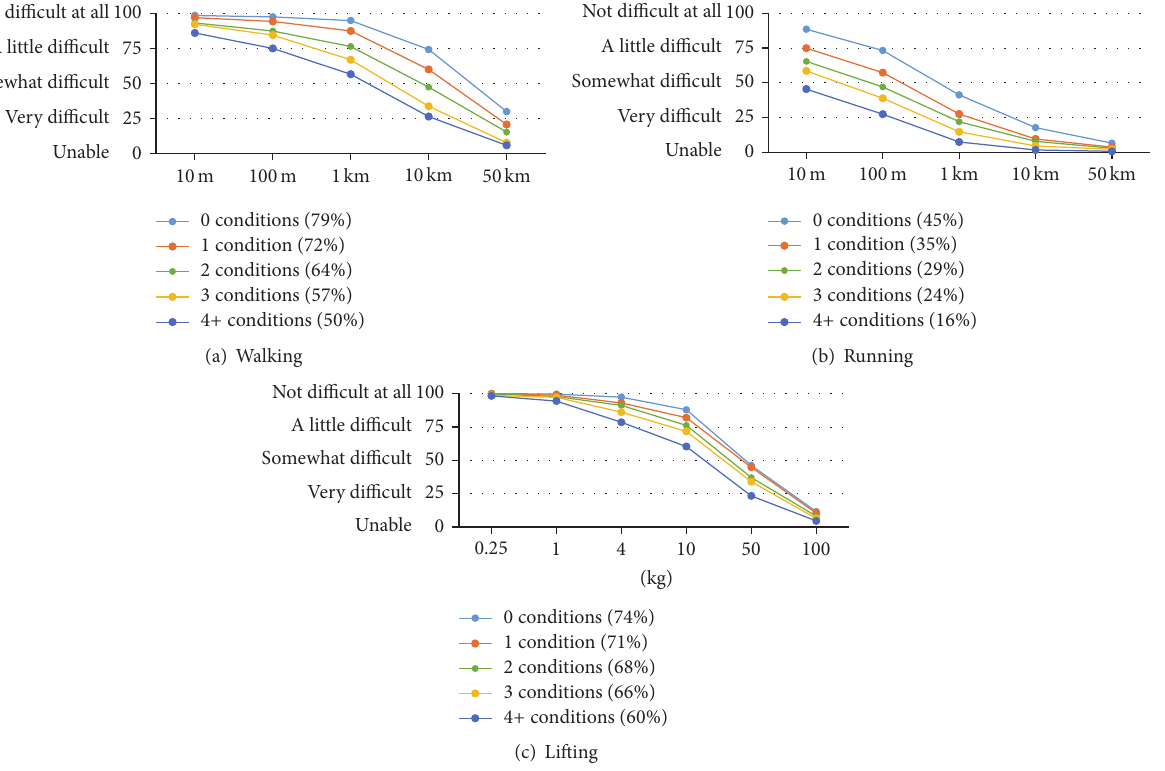
Figure 4: Mean walking, running, and lifting ability curves and summary scores by number of conditions. Table 3: Correlations of summary scores for walking, running, and lifting abilities with CAT-5D-QOL and SF-36 domain scores. Walking Running